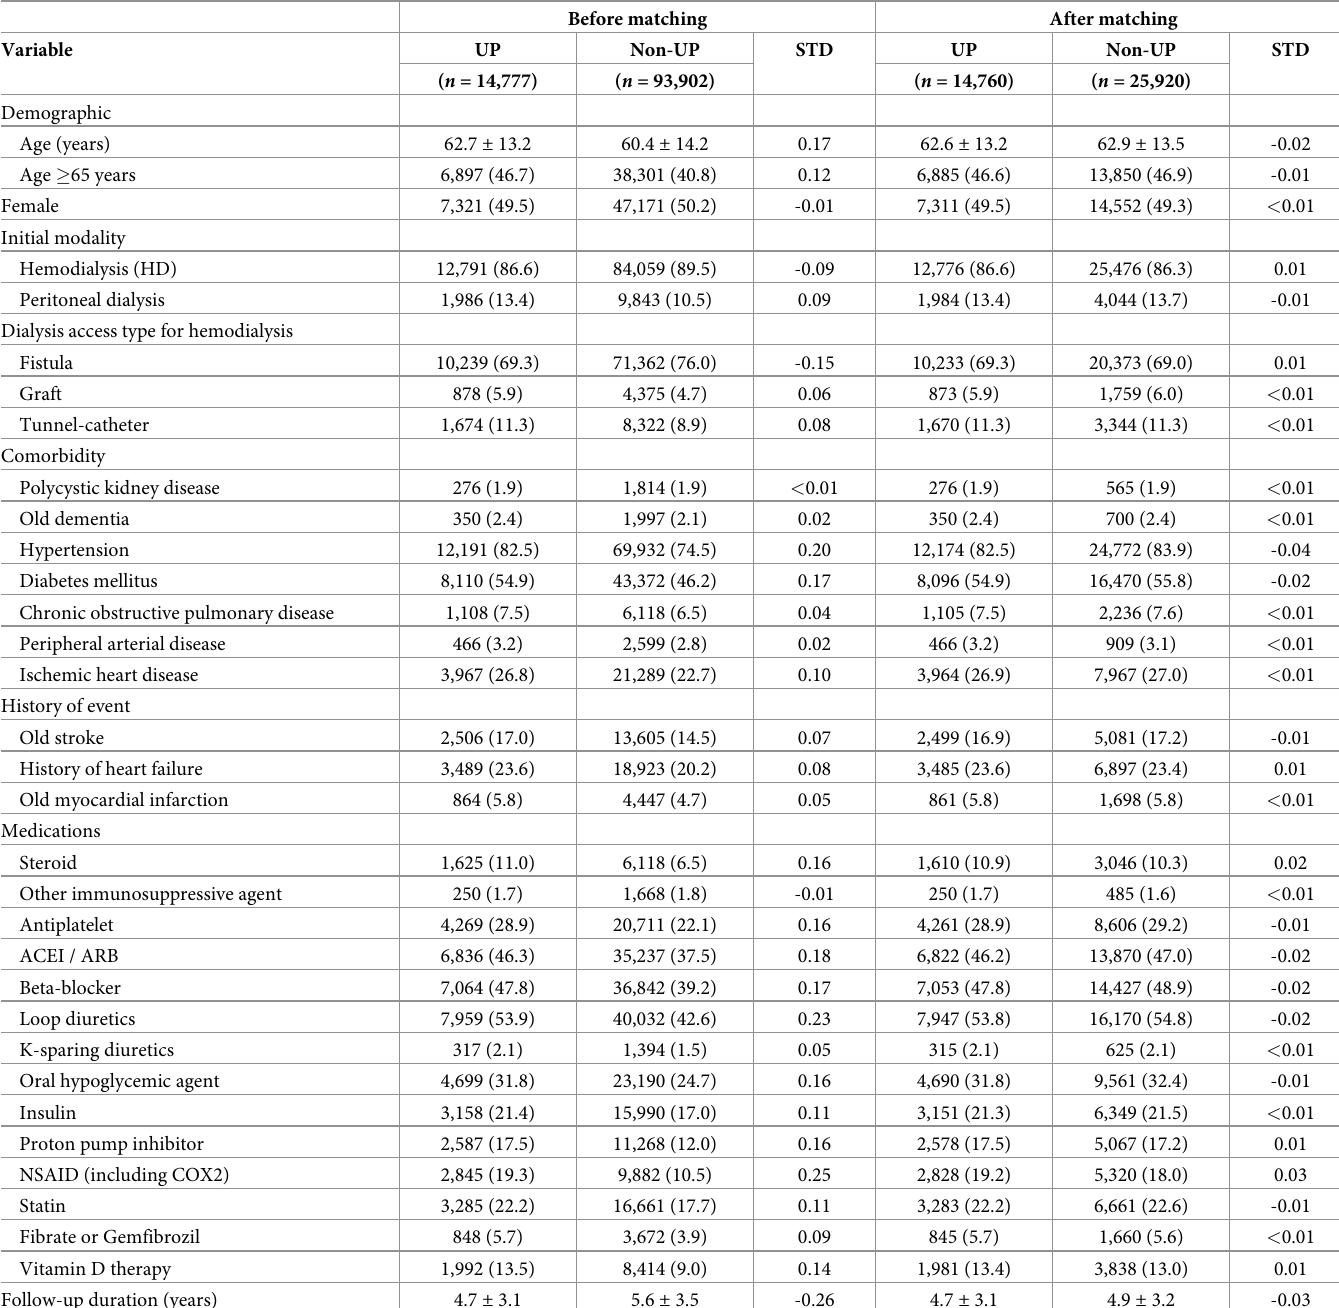
Table 1. Baseline characteristics of dialytic patients with and without uremic pruritus.